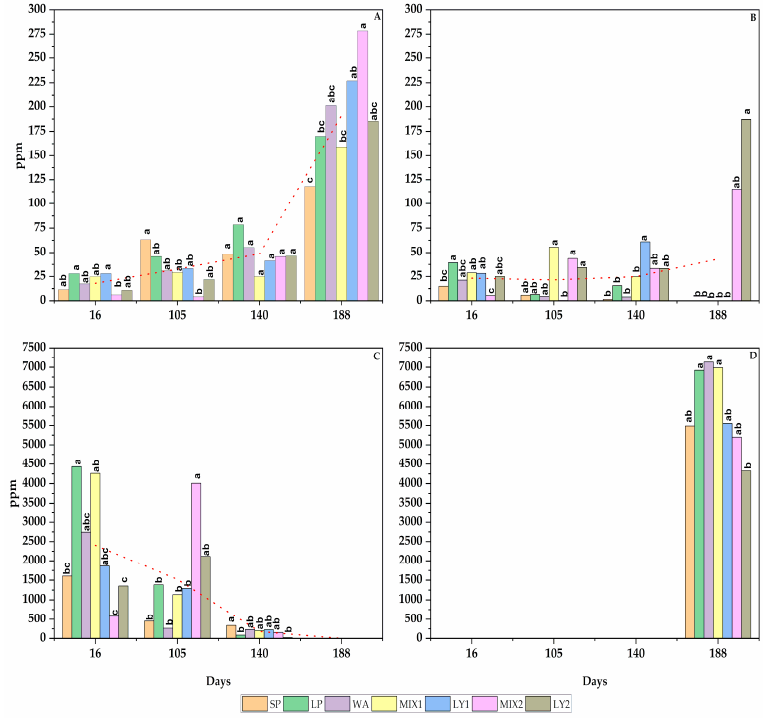
Figure 2. Glucose ( A ), fructose ( B ), mannitol ( C ) and sorbitol ( D ) evolution of the brines during fermentation. The data are expressed as means of triplicate measurements. Significant differences (LSD) are indicated by different letters ( p ≤ 0.05). The red dotted line represents the average values at each sampling time. Fermentation 2023 , 9 , x FOR PEER REVIEW